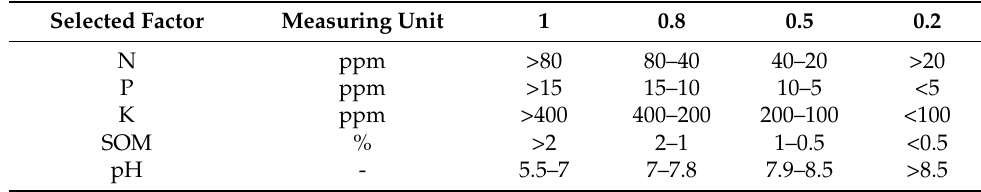
Table 2. Score factors of SFC parameters.